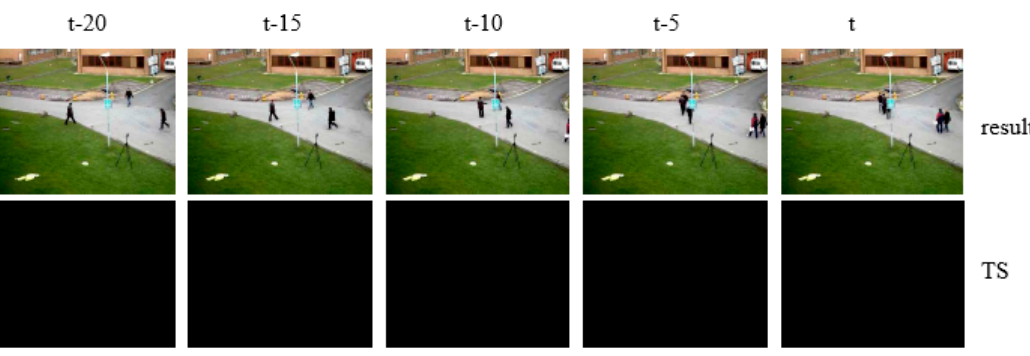
Figure 11. Examples of detection results for abnormality from the No. 4 data (Avenue).